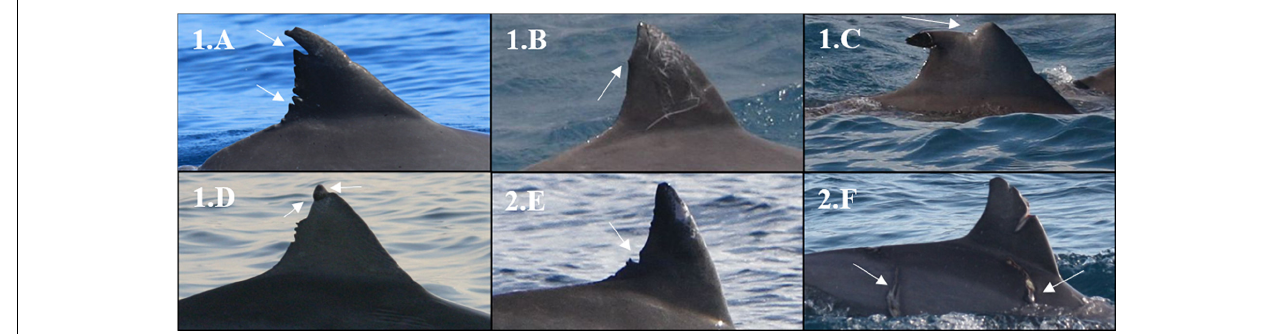
FIGURE 4 | Examples of injuries observed on Indo-Pacific bottlenose dolphins in the southern range of New Caledonia. Injuries were probably from human-related origin characterized by (1.A) : straight and parallel deep cuts on the trailing edge generally caused by a propeller hit. (1.B) : linearly severed top of dorsal fin generally caused by a propeller hit. (1.C) : straight deep cut on the leading edge likely caused by a propeller hit. (1.D) : opposite cuts on the tops of the dorsal fins generally caused by fishing gear interaction. Natural origin characterized by (2.E) : v-shaped cut on the trailing edge mostly caused by inter or intra-specific interactions (2.F) : crescent shaped bite marks on the flank of the body mostly caused by shark